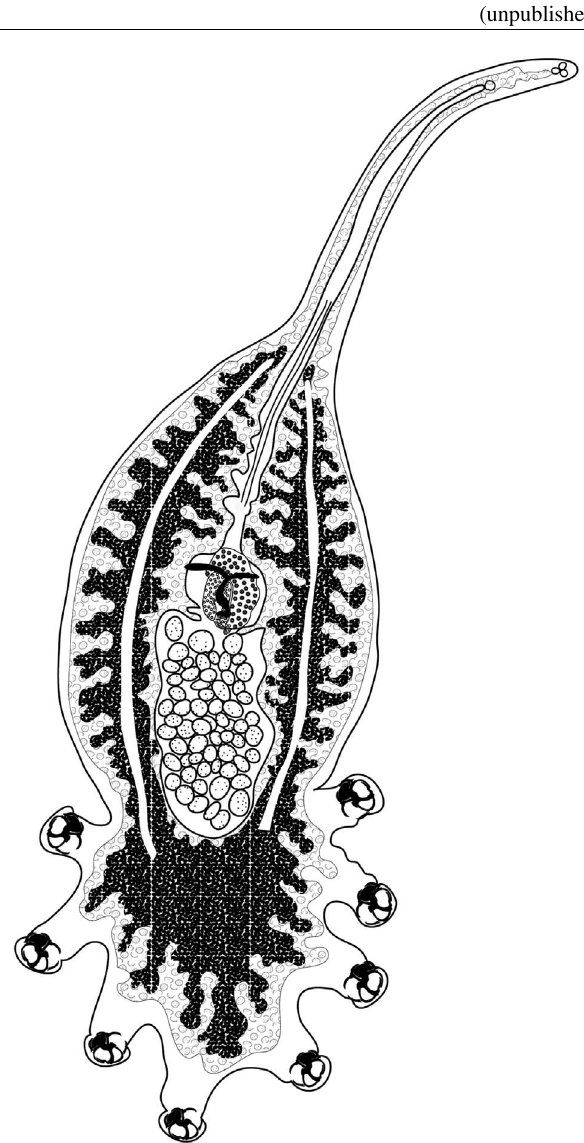
Figure 1. Cyclocotyla bellones Otto, 1823. Whole body, MNHN